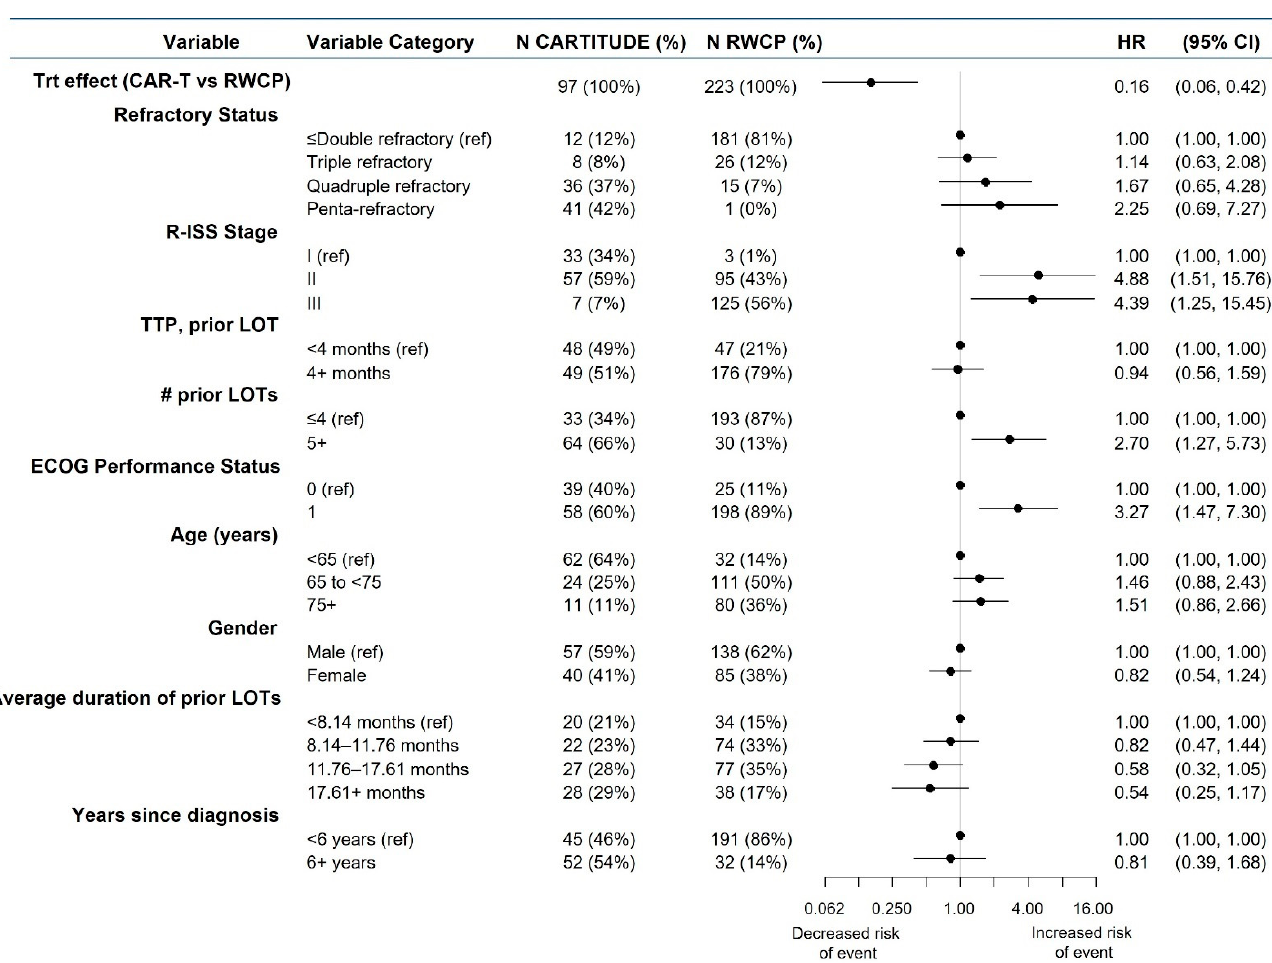
Figure 3 . Overall Survival, mITT comparison, Covariate Effects from Cox PH Multivariable Regression Analysis. The clinical effects associated with the modeled covariates in a multivariable Cox proportional hazards regression model for OS are presented based upon data from the mITT population. R-ISS stage was derived for both cohorts based on individual components. Abbreviations: CI, confidence interval; LOT, line of therapy; HR, hazard ratio; R-ISS, Revised International Staging System; RWCP, real-world clinical practice; Trt, Treatment.